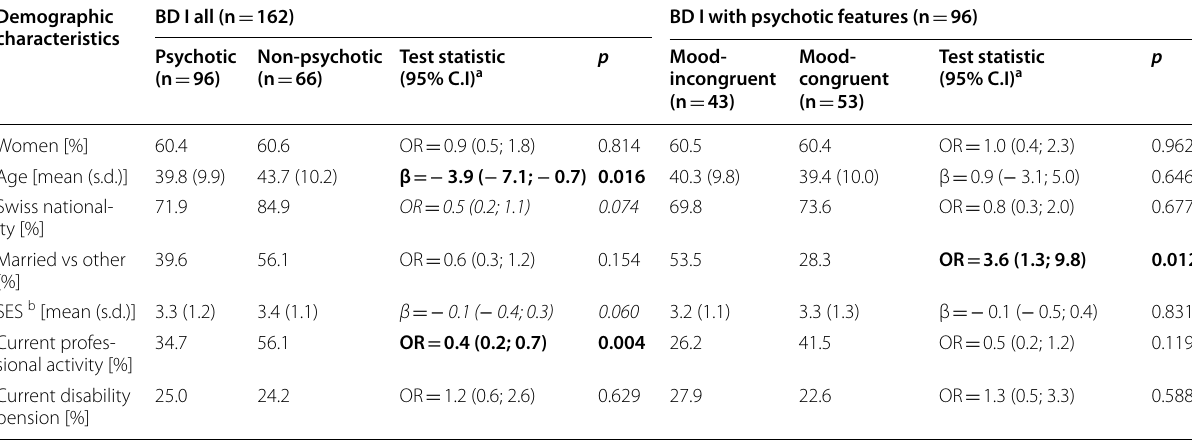
Statistically significant differences are indicated in bold. Additional variables reaching the level of p < 0.1 are indicated in italic BD I bipolar I disorder a Models (one model per line) adjusted for sex and age (sex adjusted for age, age adjusted for sex); p p-value, SES socio-economic status b A value of 3 represents an SES of III (middle class) on the Hollingshead scale